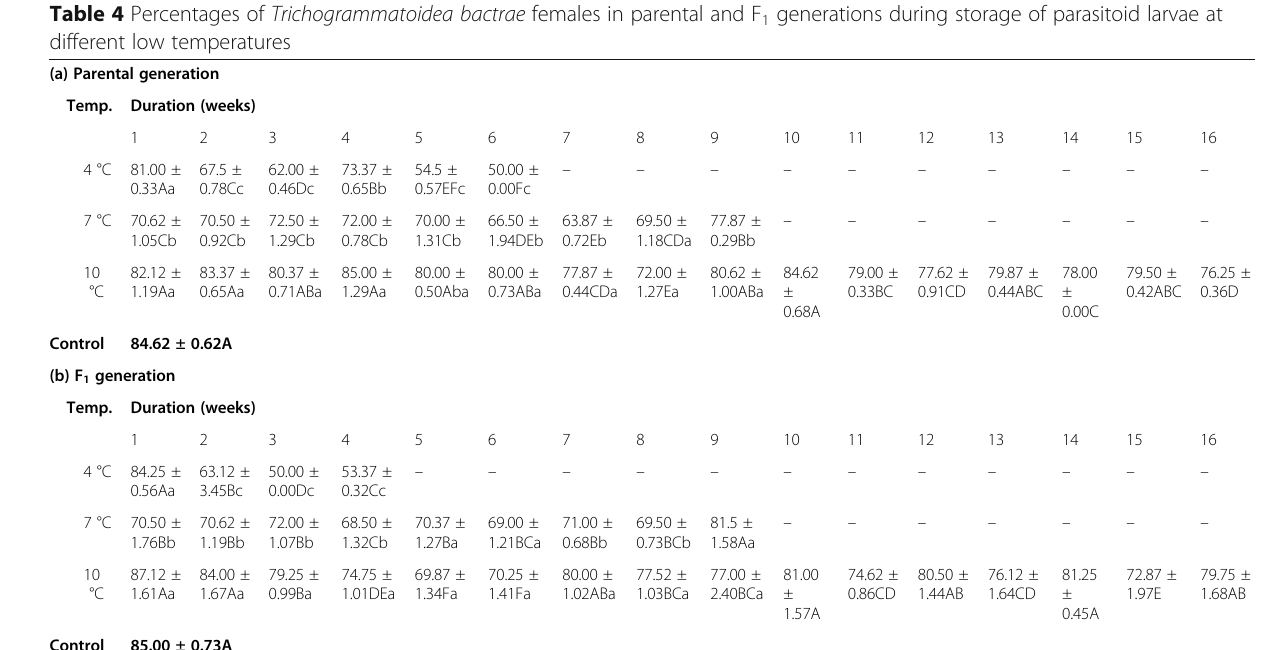
Means ± SE sharing the same capital letters in the same row, and same small letters in the columns are statistically insignificant ( P ≥